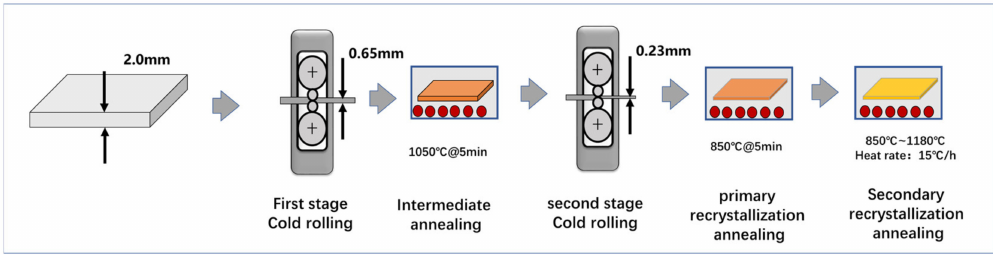
Figure 2. The schematic diagram of two-stage cold rolling